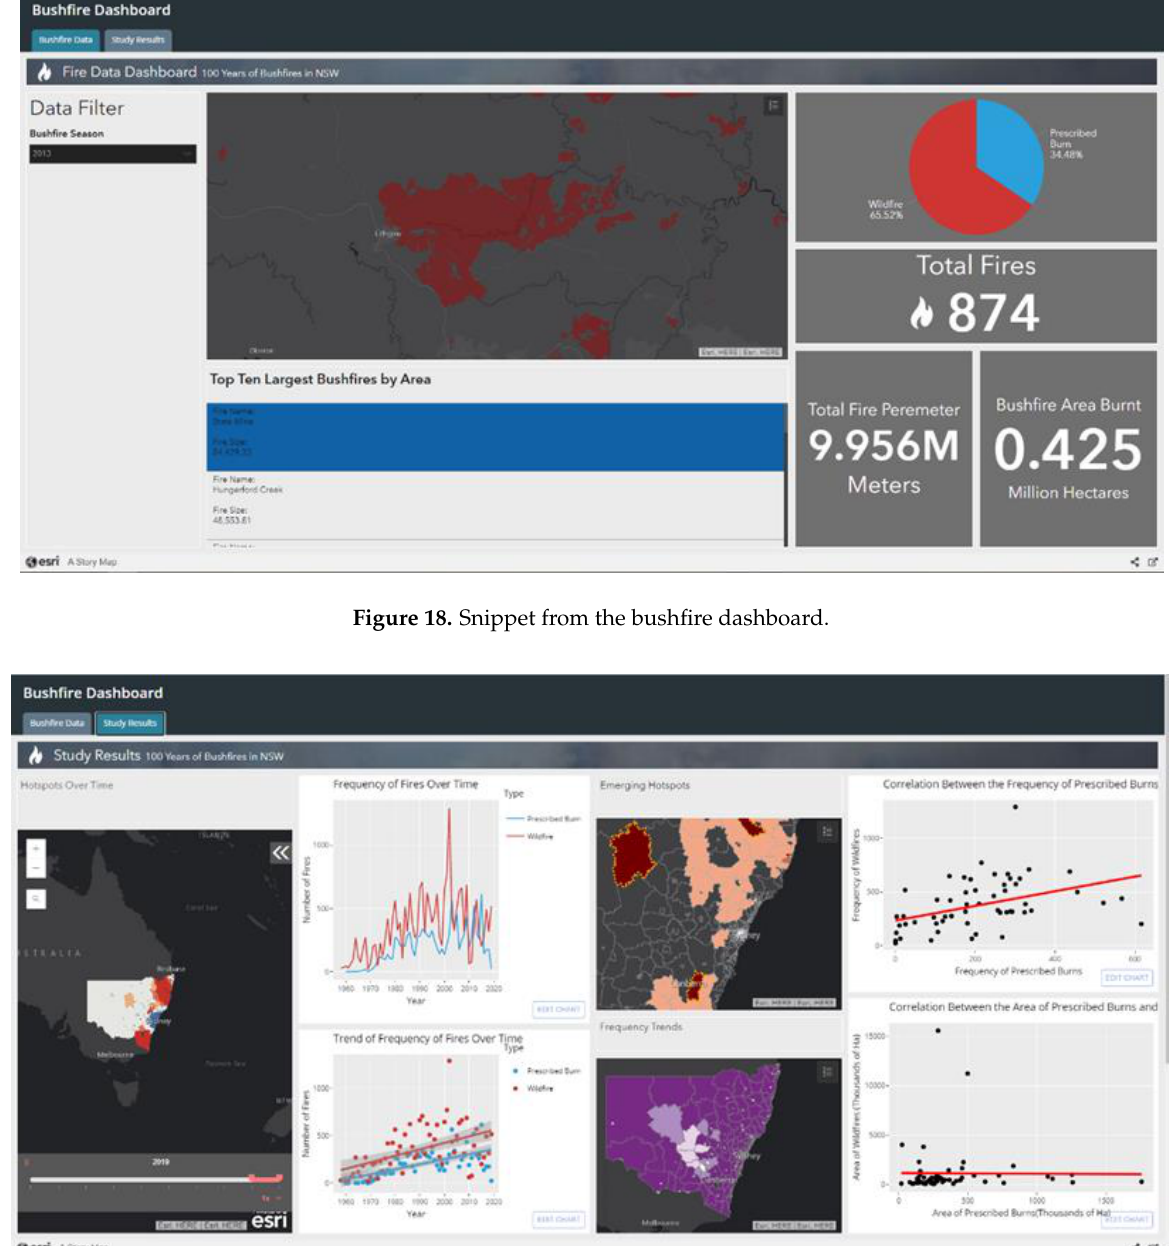
Figure 19. The results section of the bushfire dashboard.